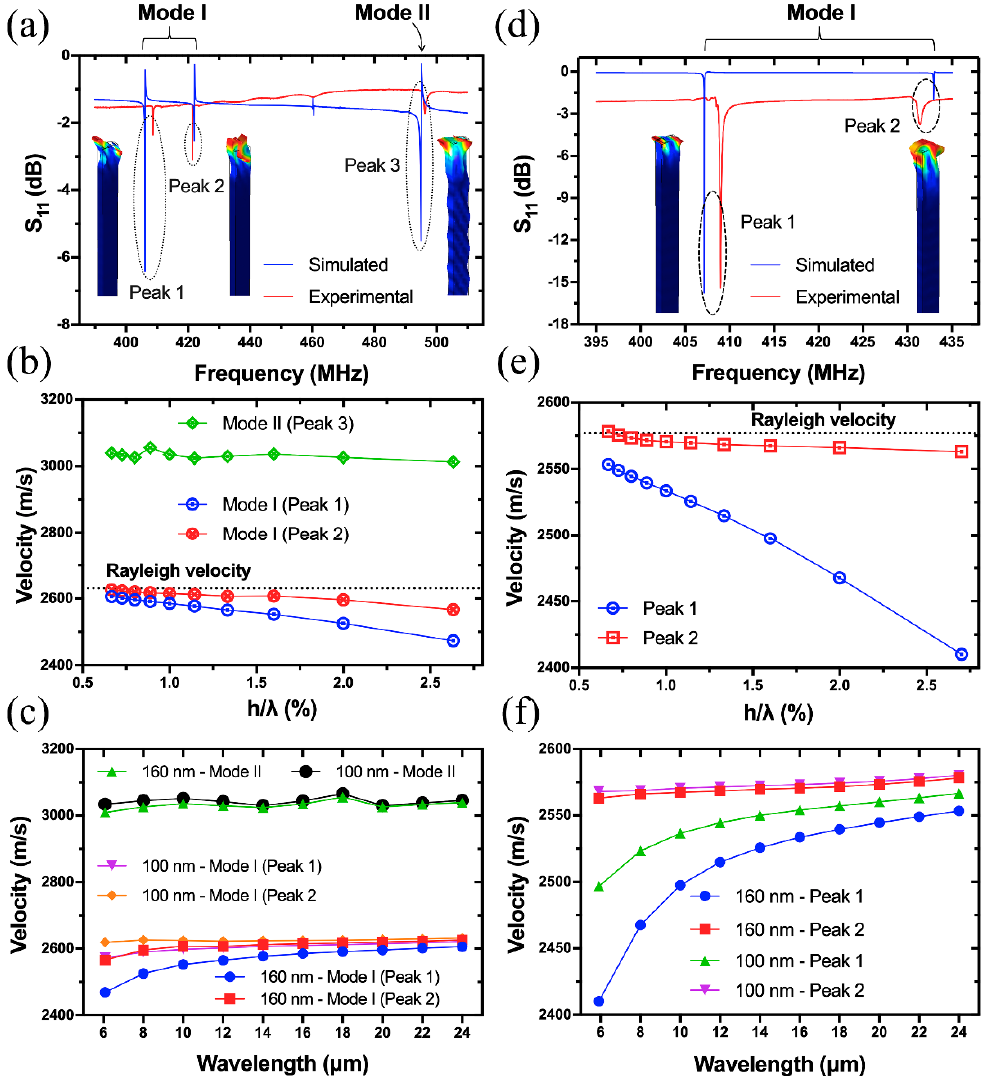
Figure 7. Comparison of the simulated and experimental S 11 spectra of Device B ( λ = 6.08 µ m) ( a ); Dispersion relations between acoustic velocity and normalized Pt electrode thickness ( h / λ ) for the two modes of Device B ( b ); Modulation e ff ect of Pt electrode thickness on acoustic velocities of Device B ( c ); Comparison of the simulated and experimental S 11 spectra of Device C ( λ = 5.92 µ m) ( d ); Dispersion relationship between acoustic velocity and normalized Pt electrode thickness ( h / λ ) of Device C ( e ); Modulation e ff ect of Pt electrode thickness on acoustic velocities of Device C ( f ).